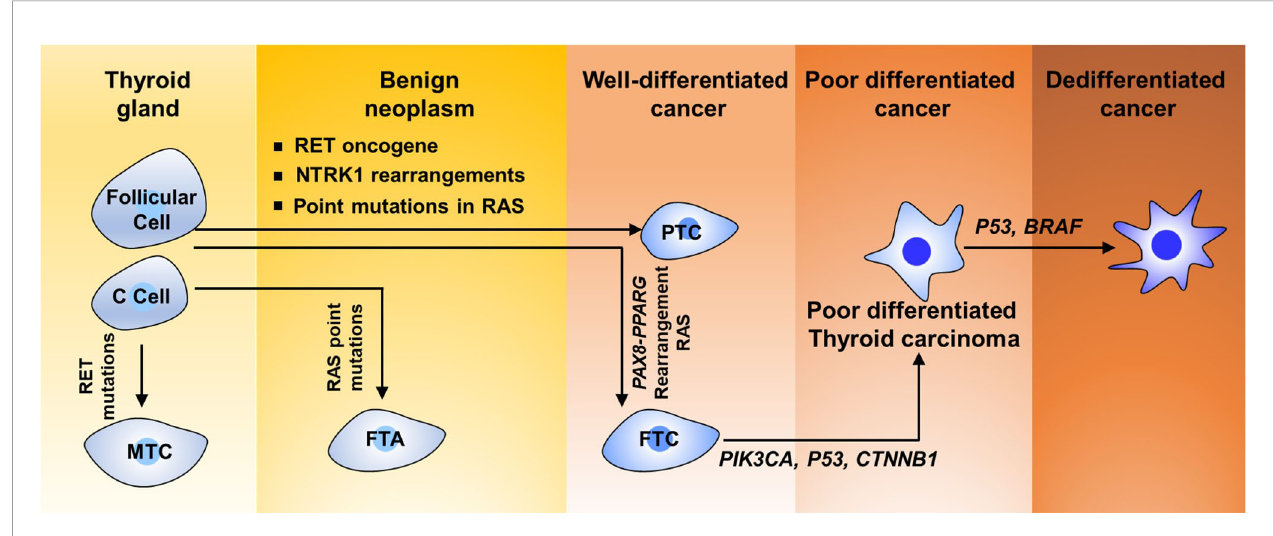
FIGURE 1 | Scheme of the status of dedifferentiation of thyroid